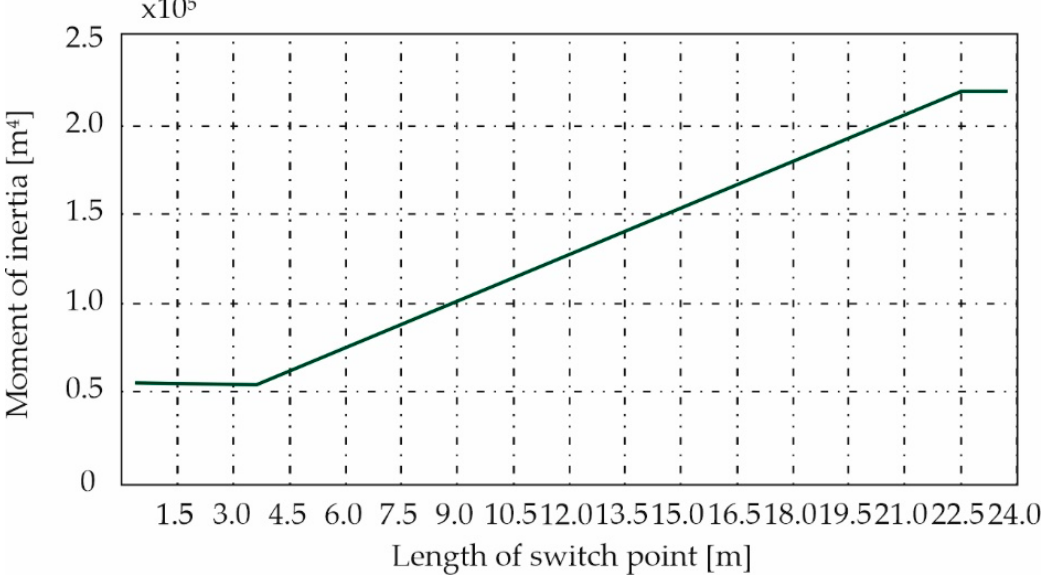
Figure 5. Diagram of the moment of inertia change for a beam with a variable cross-section.